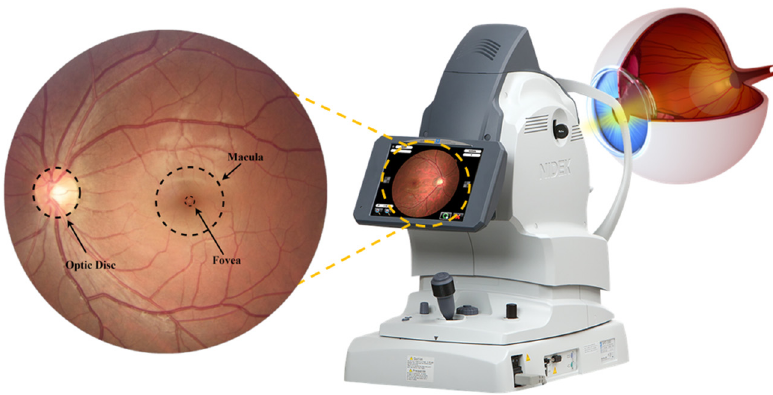
Figure 1. Representation of capturing an image of the interior surface of the eye (retina).